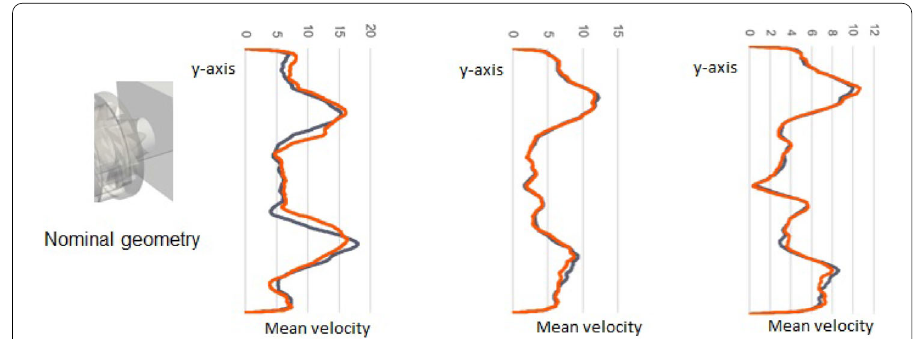
Fig. 54 Reference geometry: comparison of the recirculation zones obtained respectively as a consequence of the dissipative Galerkin ROM by (cid:3) E in orange and the HF LES in black